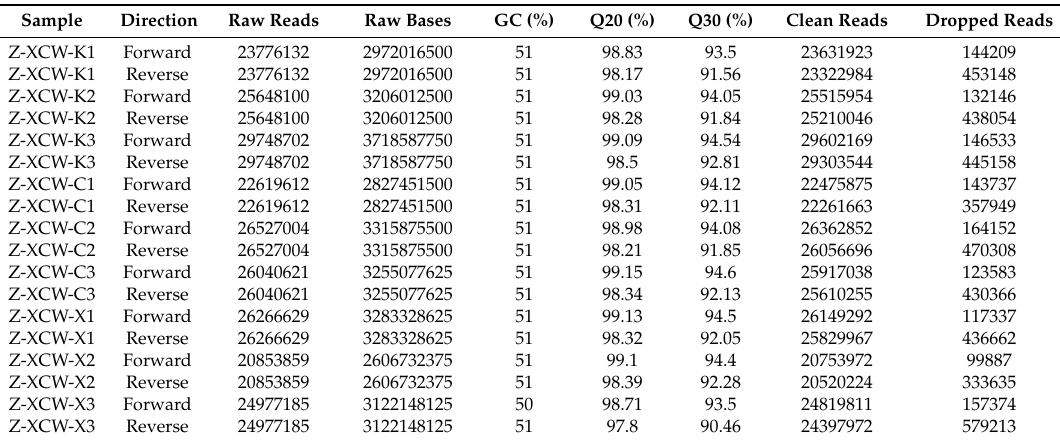
Table 1. Transcriptome sequence data.